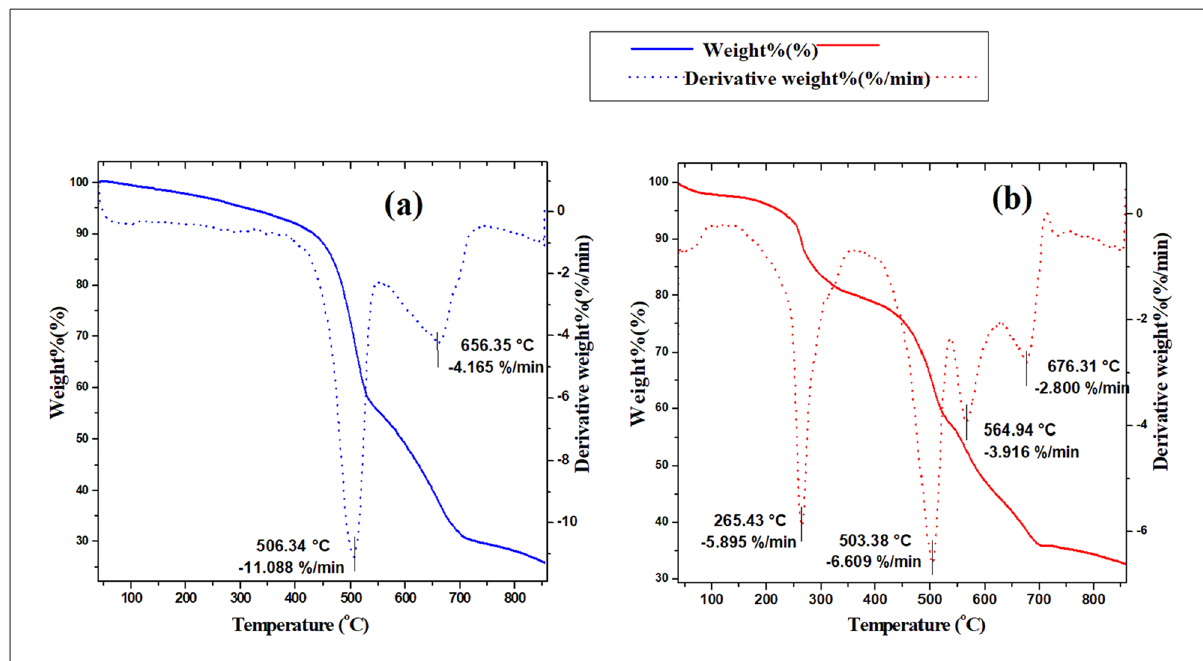
Figure 3: TG/DTA curves of ( a ) CdS@ZIF - 8 and ( b ) CTAB - capped CdS@ZIF -